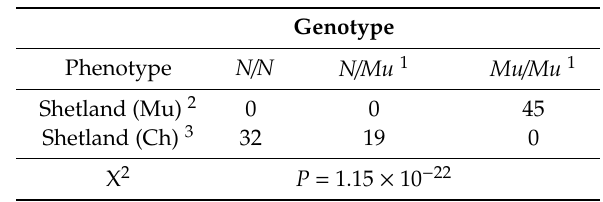
Table 3. Genotyping results for MFSD12 c.600dupC in Shetland Ponies. Presented are results for the phenotyped sample set of Shetland Ponies (mushroom and chestnut) and the p-value for the mushroom associated variant.